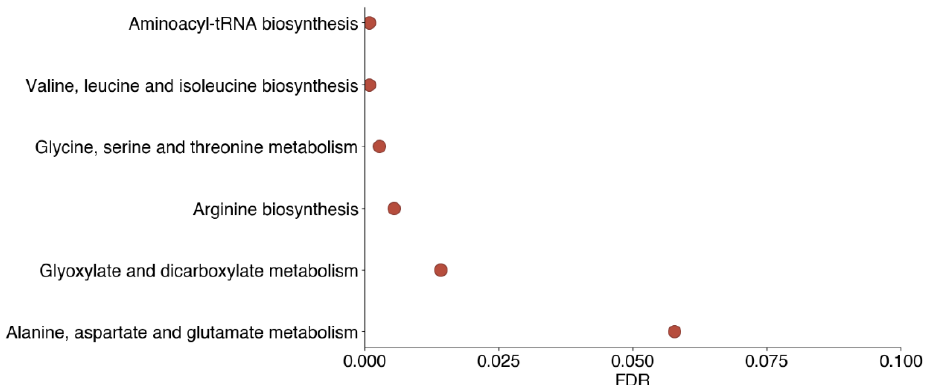
Figure 3. Pathway enrichment among heritable metabolites downregulated in COVID-19. Down-regulated metabolites were identified from both [8,9], and metabolites with ≥ 30% heritability in erythrocytes were identified. Pathway enrichment was determined using MetaboAnalyst. Three metabolites (4-vinylphenol sulfate, N-delta-acetylornithine, and succinylcarnitine) were not available in the MetaboAnalyst database and were excluded from this analysis.